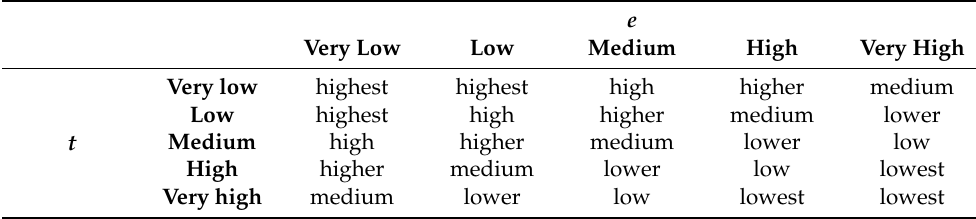
Table 1. Fuzzy rule table for u.